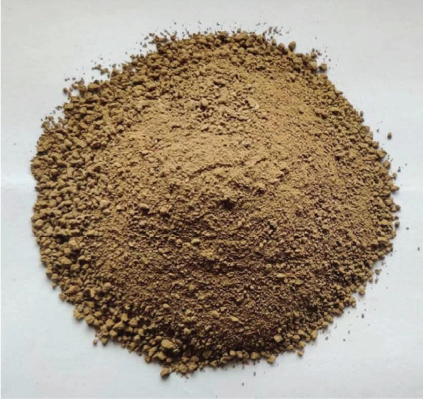
Figure 1: Test soil Table 1: Basic properties of the test soil.